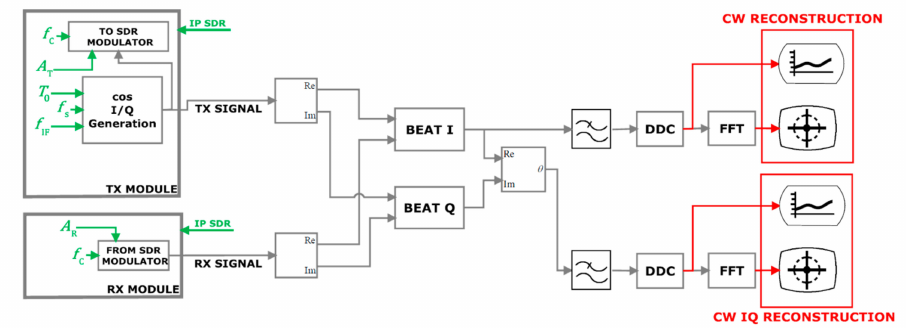
Figure 5. Software architecture of SDRadar with Doppler